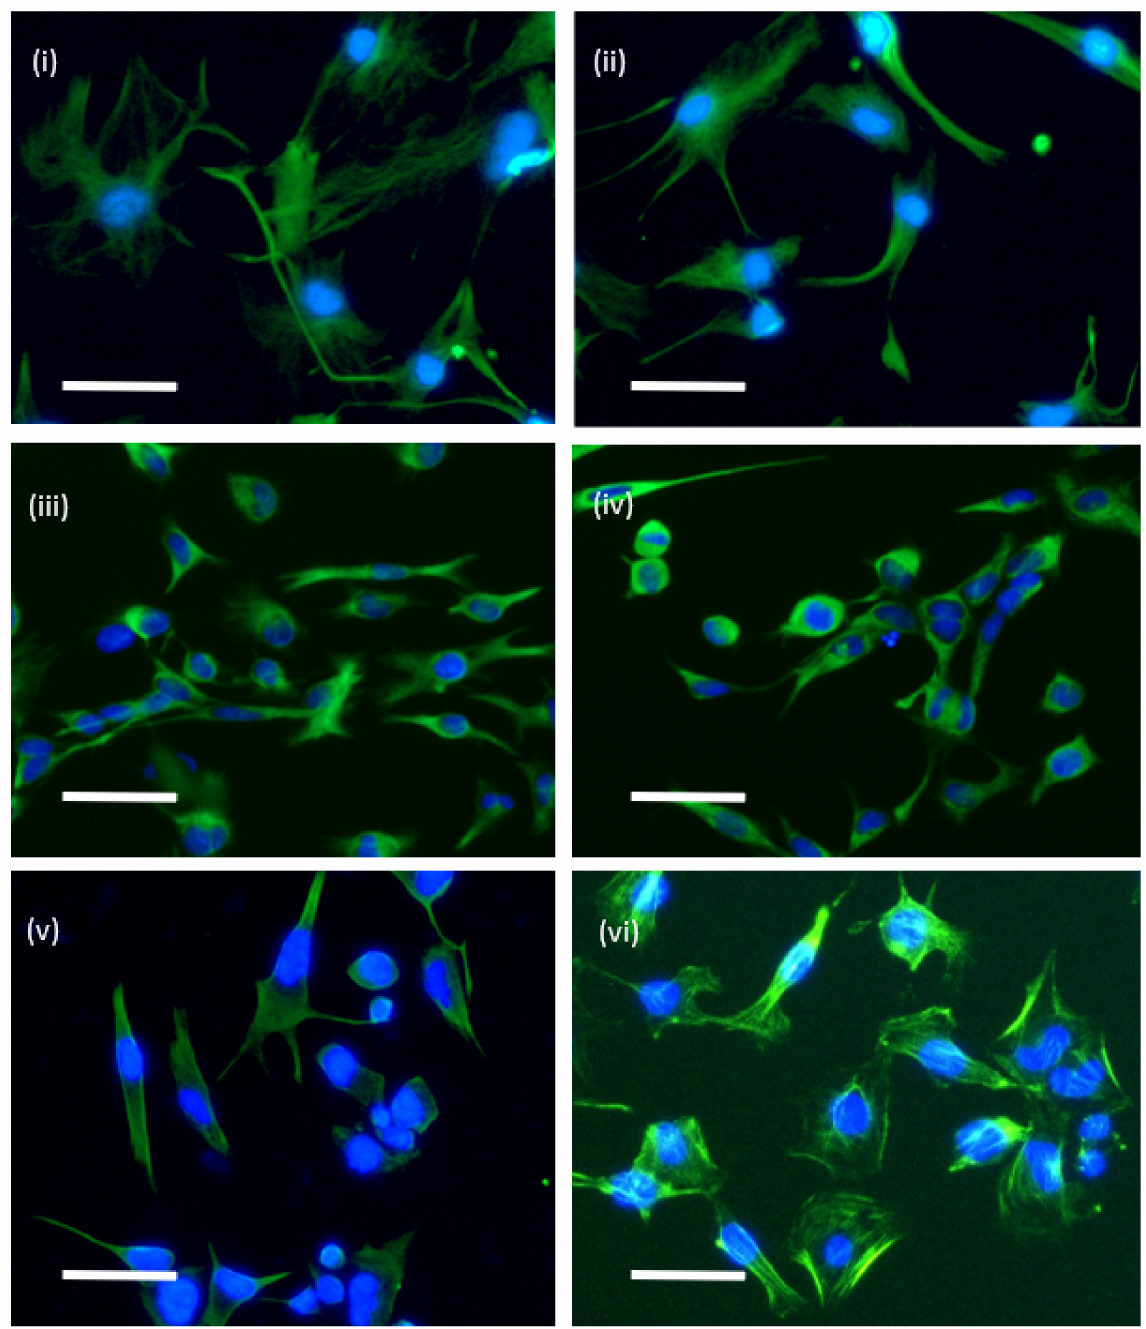
Figure 2. Morphology of adherent glioblastoma stem-like cells. The cells were stained for various cytoskeletal intermediate filaments to optimally reveal the cellular morphology and adherent shape of the cells. Cells were seeded at low density (5000 cells per well) and grown on laminin for 2–3 days. All images are from stem cell cultures of ( i ) and ( ii ) NZB11 stained for nestin, ( iii ) and ( iv ) NZB19 stained for nestin, ( v ) NZB12 stained for nestin, and ( vi ) NZB12 stained for actin. Scale bar is 50 µ